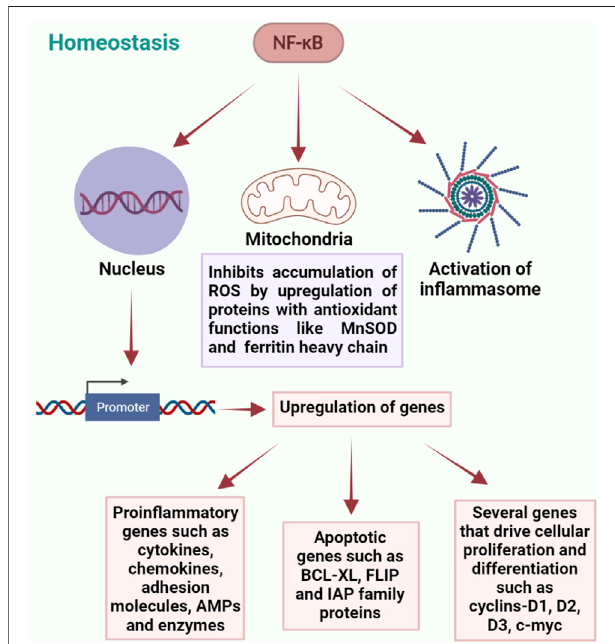
FIGURE 1 | Diverse roles of NF- κ B in regulation of homeostasis. NF- κ B plays a central role in maintaining homeostasis through a complex network of interactionsinvolvingregulationofgeneexpression,maintainingmitochondrial ROS levels and activation of in fl ammasomes.